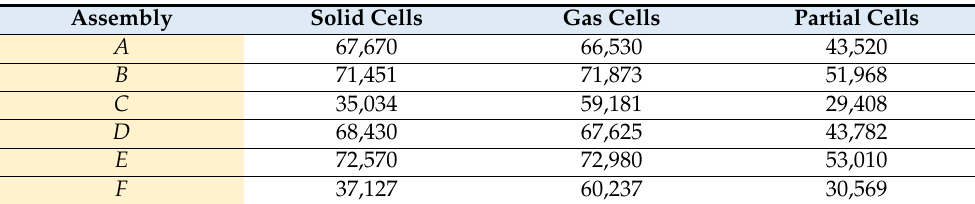
Figure 9. Simulation conditions. Table 2. Number of cells in 3D models of tested assemblies.